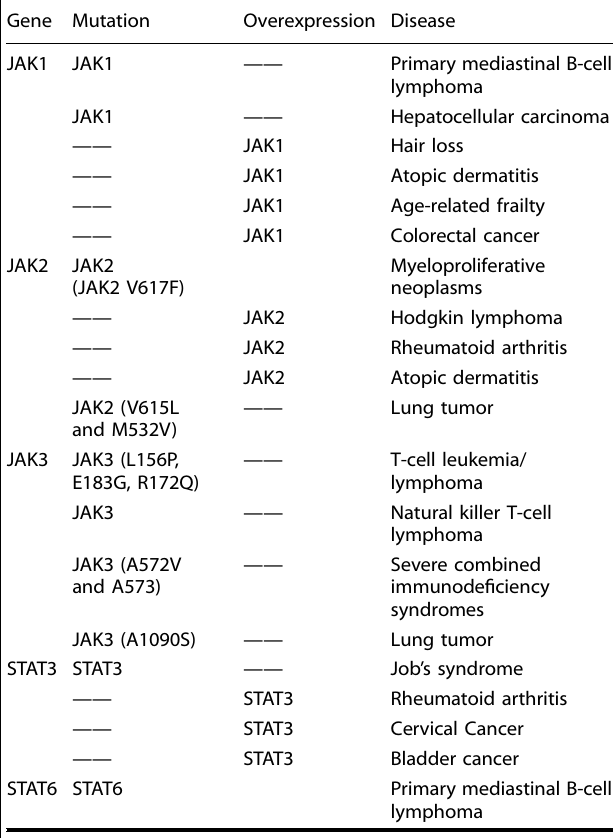
Table 3. Mutation or overexpression of JAK/STAT at different diseases Gene Mutation Overexpression